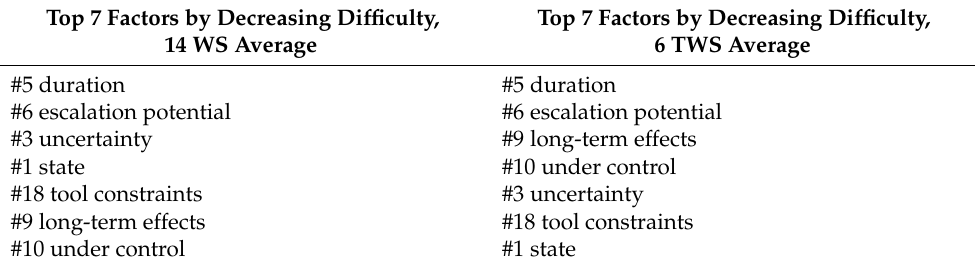
Table 8. Top 7 factors (out of 13 queried) by decreasing difficulty, 14 watch supervisors’ (WS) and 6 technical watch supervisors’ (TWS) averages. Table 6 describes the factors from the exercise managers’